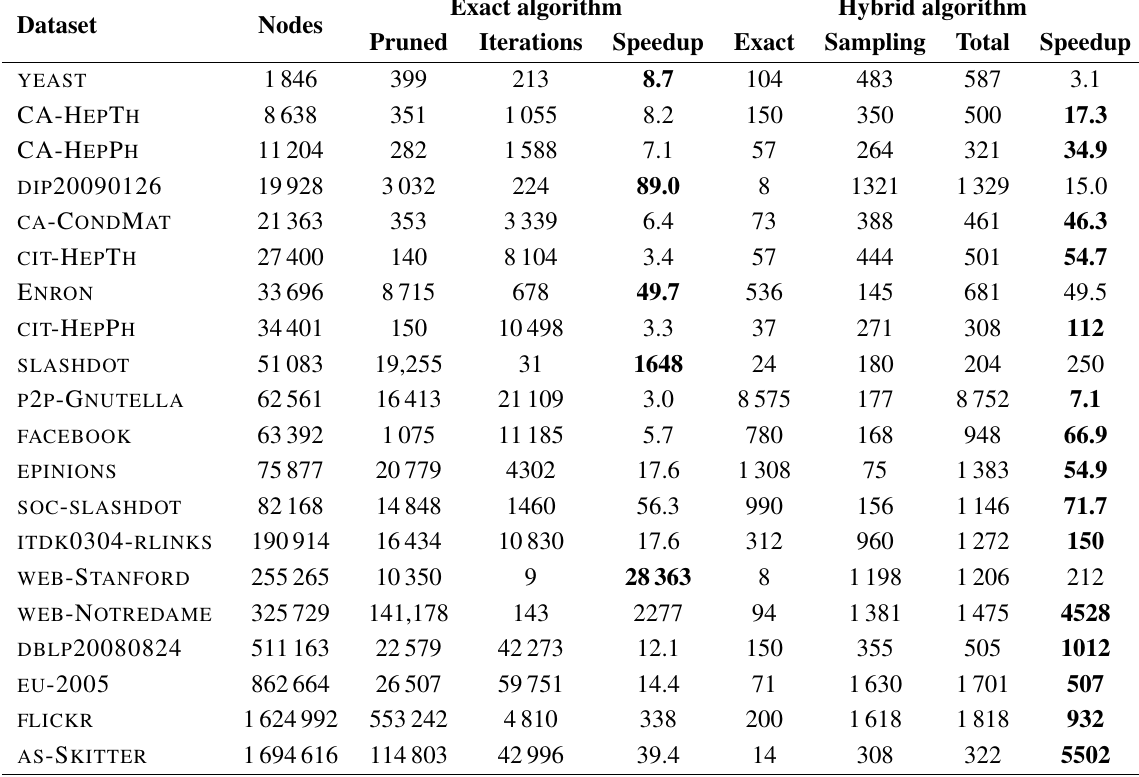
Table 2. Performance (number of pruned nodes, number of iterations and speedup) of the exact algorithm (Algorithm 2) and the hybrid algorithm (Algorithm